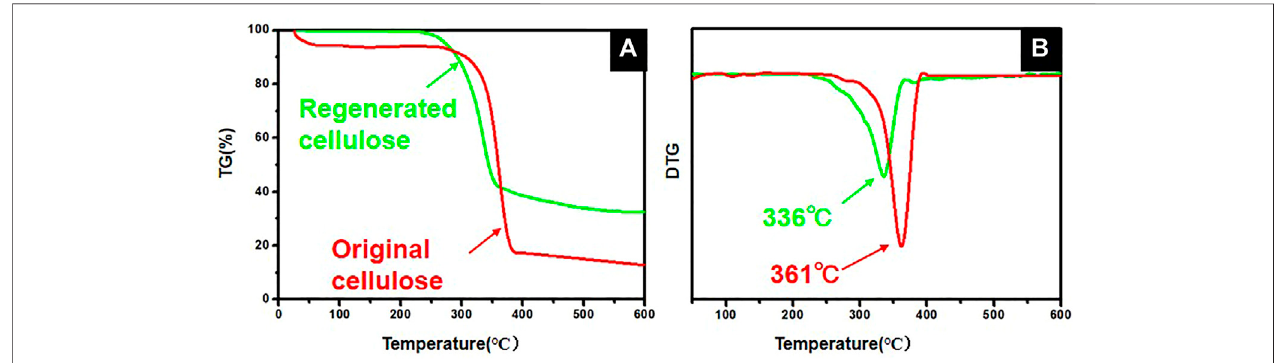
FIGURE 5 | TG and DTG curves of original cellulose and regenerated cellulose. the red lines stand for orginal cellulose, and green lines stand for regenerated cellulose in Figure 5A,B .